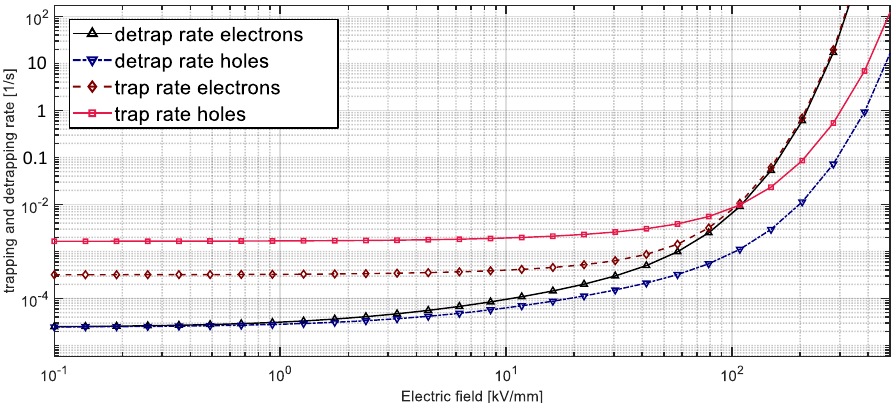
Figure 7. Trapping and detrapping rates as function of applied field at 25 °C.